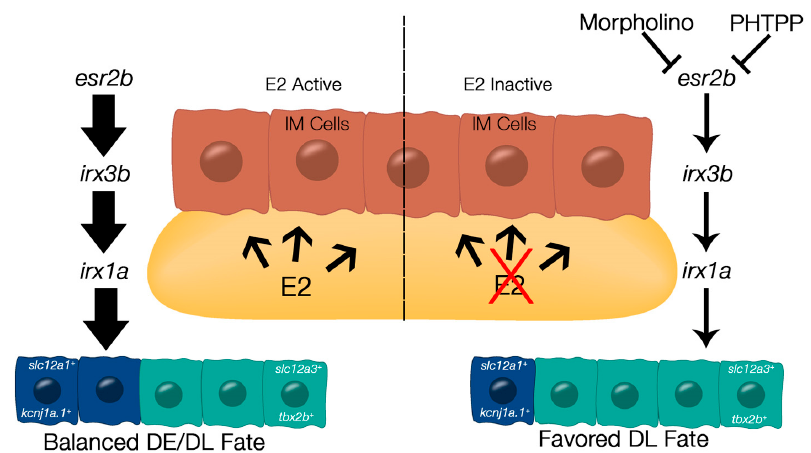
Figure 5. Proposed mechanism by which E2 signaling contributes to nephron segmentation. When E2 signaling is active (left), E2 diffuses from the yolk into the neighboring intermediate mesoderm (IM) cells. E2 binds to Esr2b, which activates irx3b and irx1a , ultimately resulting in balanced DE and DL fate. When E2 signaling is inactive (right) via morpholino knockdown or chemical inhibition by PHTPP, esr2b activity is diminished, as well as expression of downstream targets irx3b and irx1a , resulting in favored DL fate.